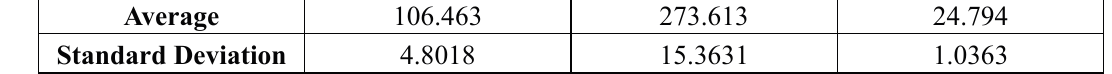
Table 11. The energies over all probe/library strand interactions.